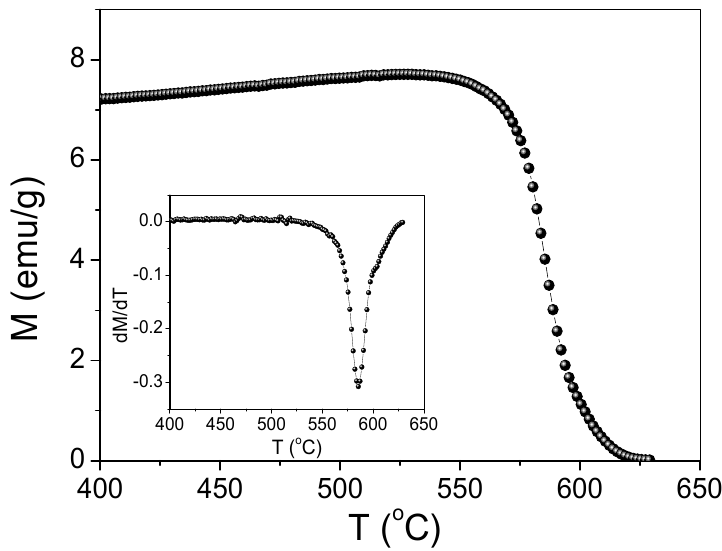
Figure 6. Thermomagnetic curve of NiFe 2 O 4 -NPs in an applied field of 100 Oe (the inset is the derivative of the thermomagnetic data).